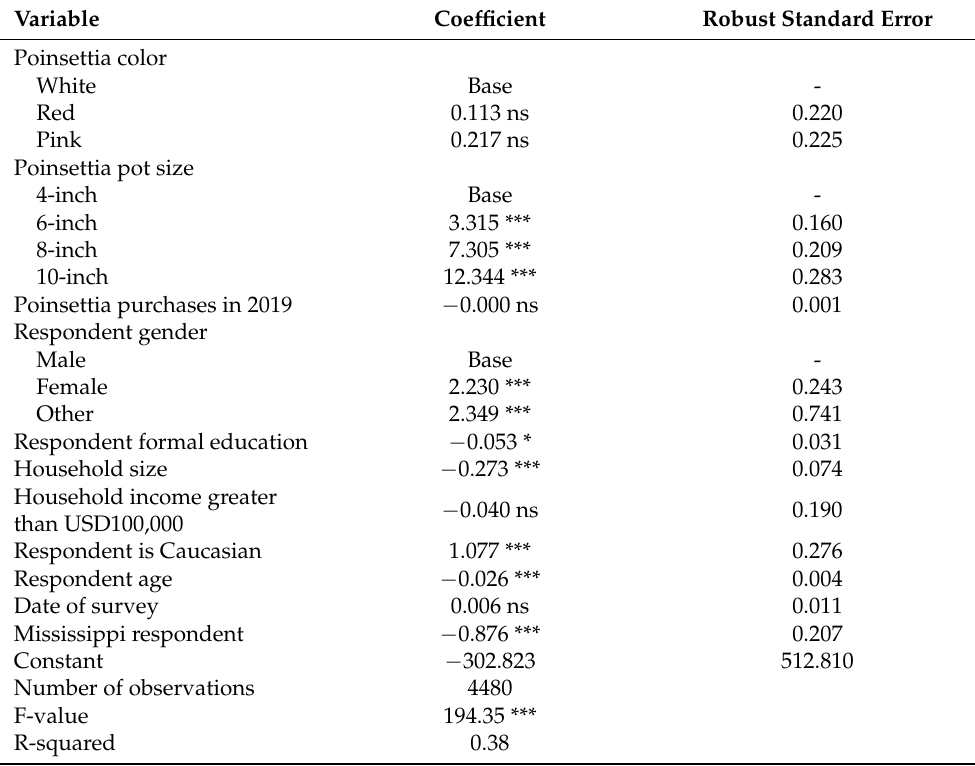
Table 8. Regression results with respondents’ willingness to pay per potted poinsettia as the depen- dent